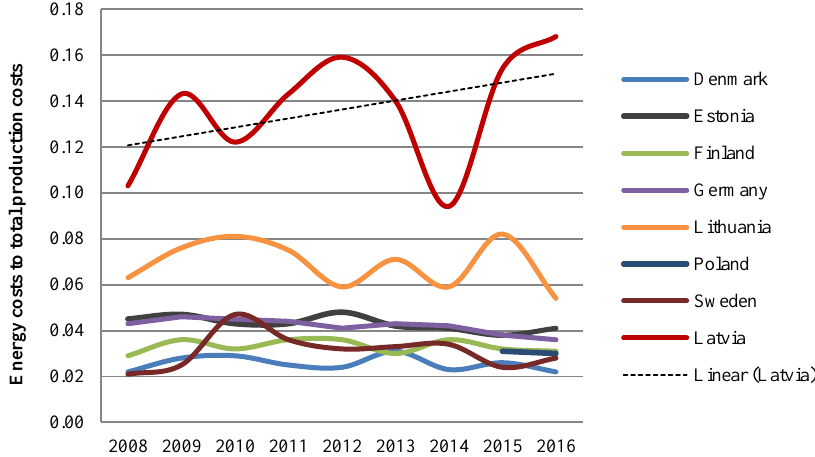
Fig. 2 . Energy costs to total production costs in wood and wood products industries (Latvia and Baltic Sea region countries). The sectoral (2-digit NACE code) data analysis of wood and wood products industries do not allow a deep analysis of the specific industries as it hides a high level of heterogeneity within the sector. In addition, as seen from the Fig. 2, in 2014 wood and wood products industries showed a deep atypical drop on energy intensity, which requires deeper subsector analyses at least at the 4-digit NACE code